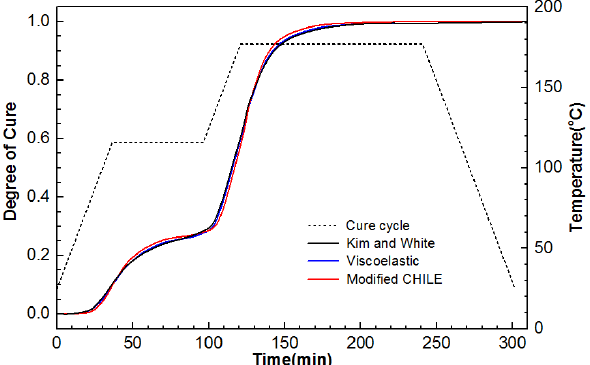
Figure 5. Degree of cure (DOC) development in central point (5.08, 5.08, 1.27) of the composite laminate under manufacture recommended cure cycle from the modified CHILE and viscoelastic models.